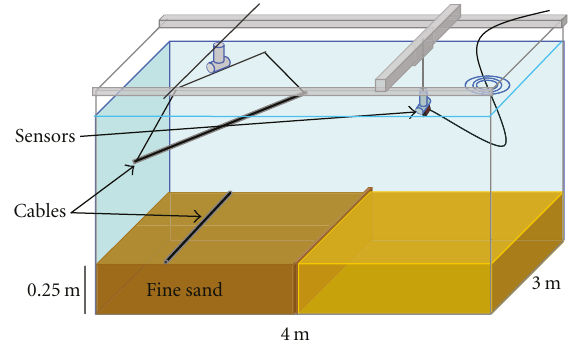
Figure 4: Diagram to show Lamb wave propagation path in cylindrical